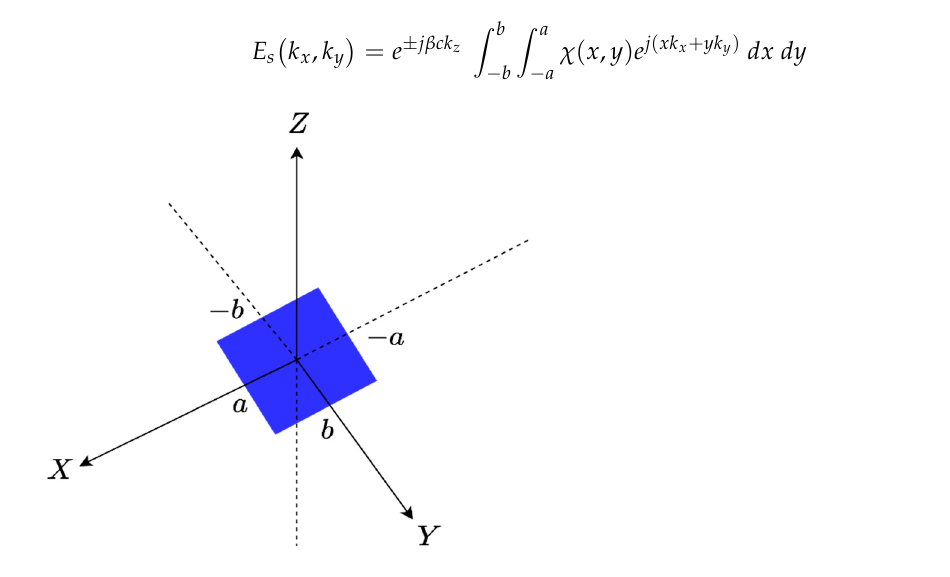
Figure 3. The geometry of the XY face ID.